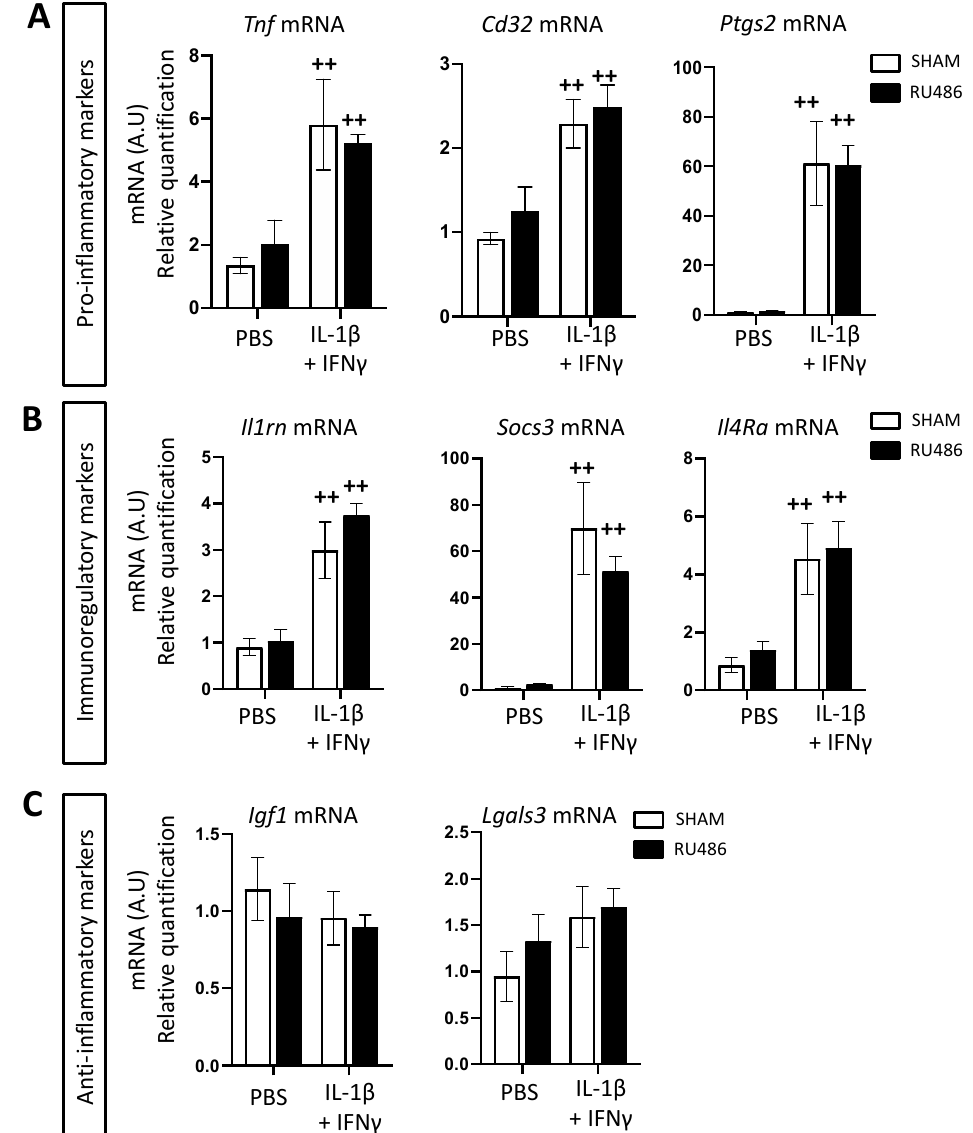
Figure 6. RU-486 exposition did not modulate microglial reactivity in vitro. CD11B+-cell-sorted microglia were treated with RU-486 at 10 − 3 M diluted in absolute ethanol (or with ethanol absolute only for SHAM group) for 1 h prior to stimulation with IL-1β + IFN-γ or with PBS as the control for 3 h. Relative expression of mRNA encoding pro-inflammatory ( A ), immuno-regulatory ( B ), and anti-inflammatory markers ( C ) of microglial reactivity ex vivo . Results of RT-qPCR are presented as fold change relative to the control group SHAM+PBS ( n = 6 wells/group). Two-way analysis of variance (ANOVA) corrected by the Sidak test (++ p ≤ 0.01 comparing IL-1 β + IFN- γ vs. PBS). In summary, direct microglial exposition to RU-486 in vitro systematically potentiated microglial reactivity after exposition to a pro-inflammatory stimulus; this was considerably different from what we observed in vivo.